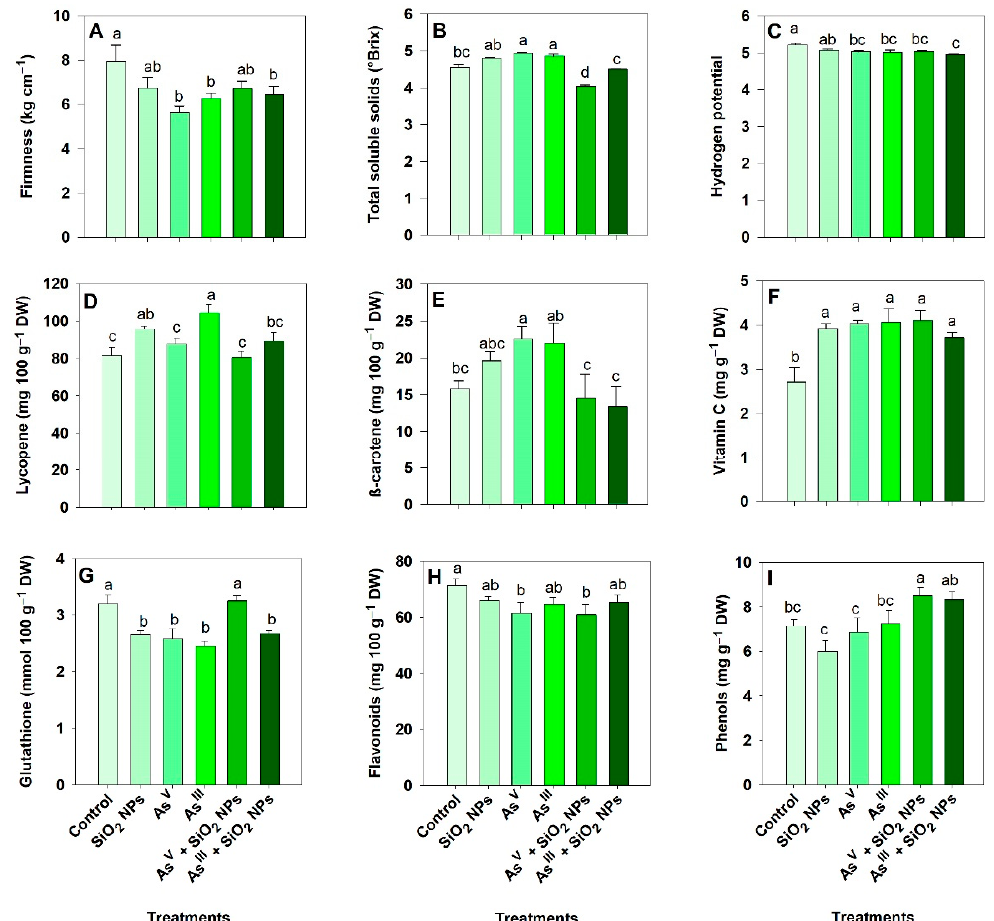
Figure 8. Quality of tomato fruits exposed to two forms of inorganic As and SiO 2 NPs, ( A ) Firmness, ( B ) total soluble solids, ( C ) hydrogen potential, ( D ) lycopene content, ( E ) β -carotene content, ( F ) vitamin C, ( G ) glutathione, ( H ) flavonoids, and ( I ) phenols. Plants treated with 3.2 mg L − 1 of As V (Na 2 HAsO 4 ∙ 7H 2 O) and As III (NaAsO 2 ) via irrigation through the nutrient solution and 1000 mg L − 1 of SiO 2 NPs via substrate. Lower-case letters different per bar indicate statistical differences according to the Fisher ′ s least significant difference test ( p ≤ 0.05). n = 5 ± standard error.